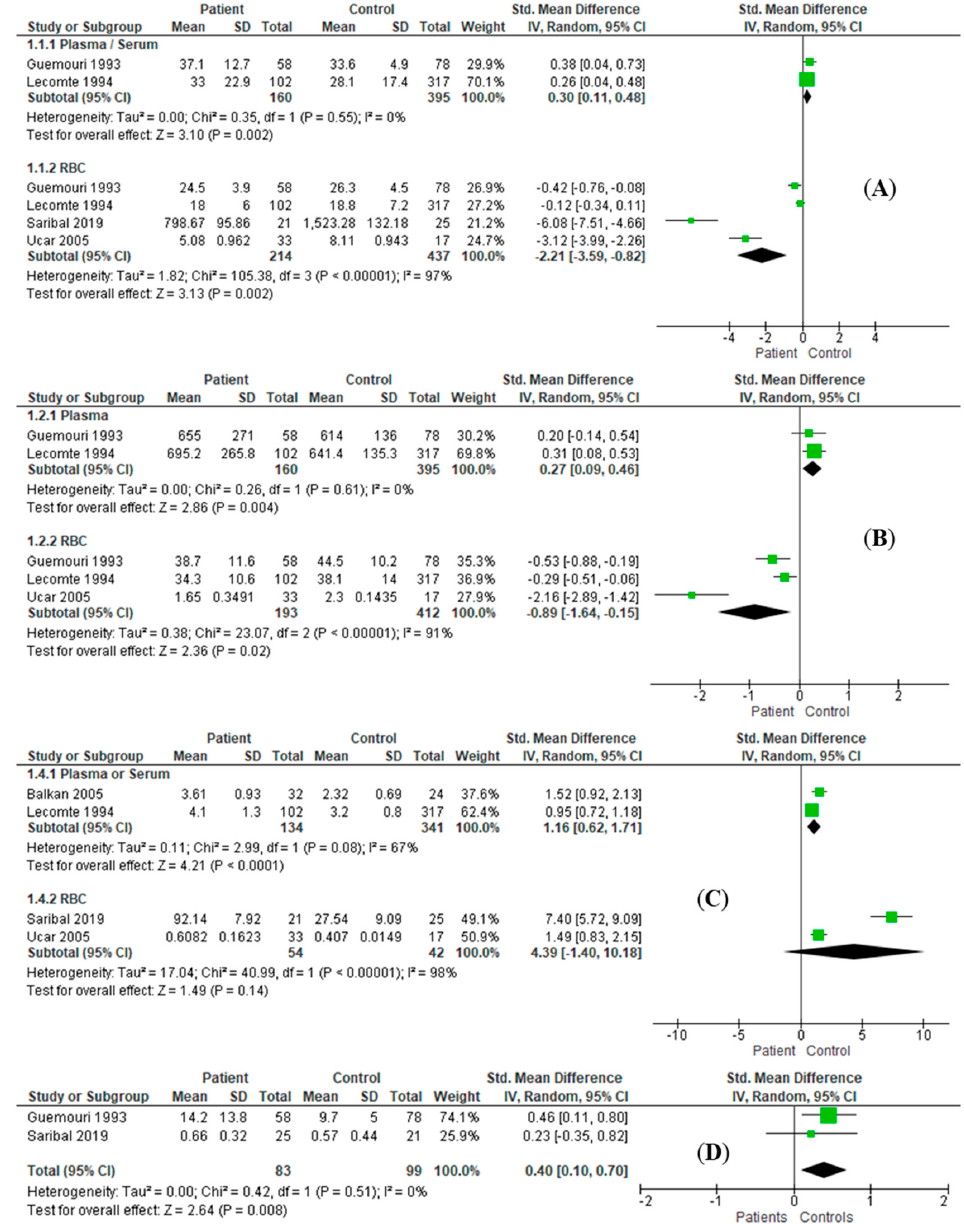
Figure 4. Different levels of antioxidants and pro-oxidants in plasma/serum or RBC between male alcohol-dependent patients and healthy male controls. ( A ) There are significant differences in SOD activity between male alcohol-dependent patients and healthy male controls in plasma/serum (RE: SMD = 0.30, I2 = 0%, 95%CI = [0.11, 0.48], Z = 3.10, p = 0.002) and RBC (RE: SMD = − 2.21, I2 = 97%, 95%CI = [ − 3.59, − 0.82], Z = 3.13, p = 0.002). ( B ) There are significant differences in GPx activity be- tween male alcohol-dependent patients and healthy male controls in plasma/serum (RE: SMD = 0.27, I2 = 0%, 95%CI = [0.09, 0.46], Z = 2.86, p = 0.004) and RBC (RE: SMD = − 0.89, I2 = 91%, 95%CI = [ − 1.64, − 0.15], Z = 2.36, p = 0.02). ( C ) Significantly different level of MDA was found in plasma/serum (RE: SMD = 1.16, I2 = 67%, 95%CI = [0.62, 1.71], Z = 4.21, p < 0.001) but not in RBC. ( D ) Significantly different level of bilirubin was found in plasma/serum (RE: SMD = 0.40, I2 = 0%, 95%CI = [0.10, 0.70], Z = 2.64, p = 0.008). CI, confidential interval; GPx, glutathione peroxidase; MDA, malondialdehyde; RBC, red blood cell; RE, random effect mode; SD, standard deviation; SMD, standard mean differ- ence; SOD, superoxide dismutase.